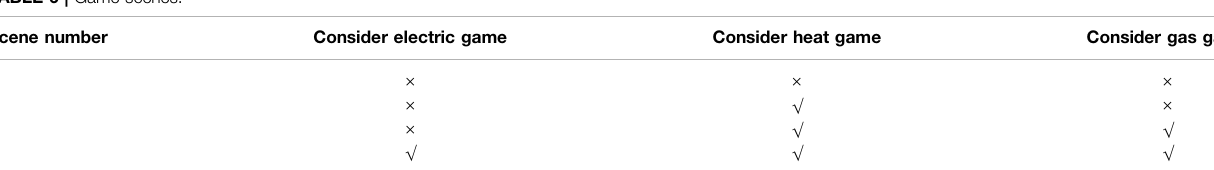
TABLE 6 | Game scenes.